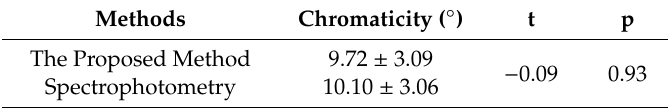
Table 4. Comparison of measurement results by two